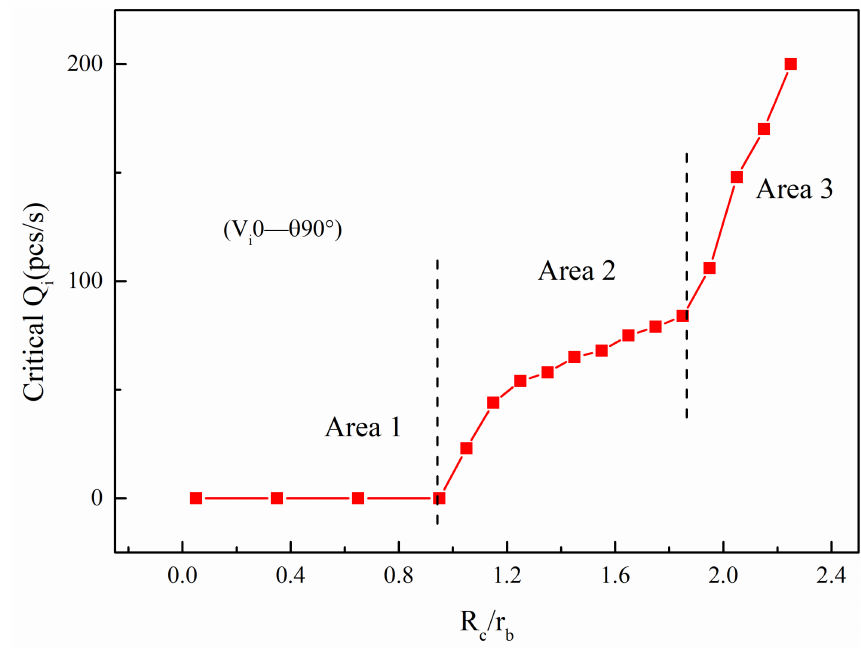
Figure 12. The critical Q i under different R c /R b